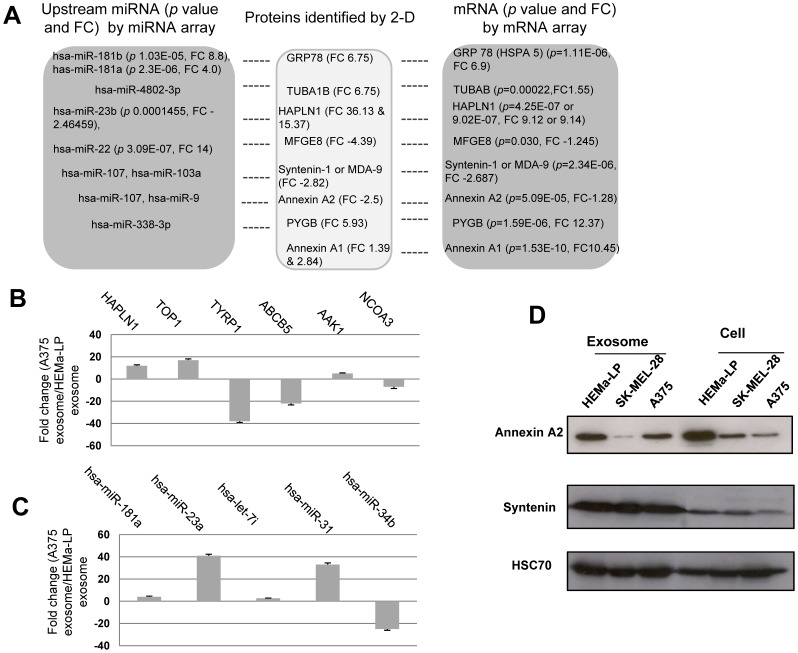
Interaction and validation of differentially expressed mRNAs, miRNAs, and proteins in A375 versus HEMa-LP exosomes.(A) Correlation of differentially expressed mRNAs, miRNAs, and proteins in A375 exosomes versus HEMa-LP exosomes (FC = fold change). Total exosomal RNA was reverse transcribed to cDNA for mRNA and miRNA validation. Expression levels of mRNA (B) or miRNA (C) were analyzed by RT-PCR. Samples were run in triplicate with at least 3 independent experiments. The bars represent normalized percentage (%) of fold change values with mean ± SD between A375 and HEMa-LP exosomes. (D) Total exosomal protein was extracted for Western blotting analysis using antibodies as designated. HSC70 was used as a loading control.